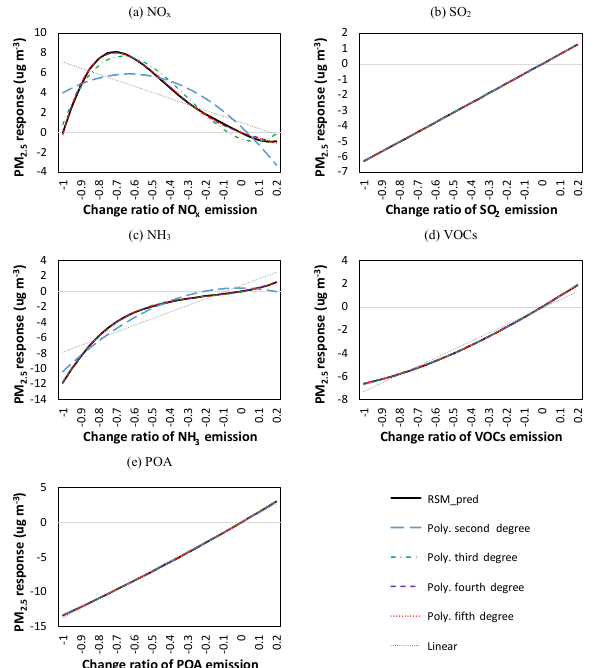
Figure 3. Fitting the PM 2 . 5 responsive function with a polynomial of a single indeterminate